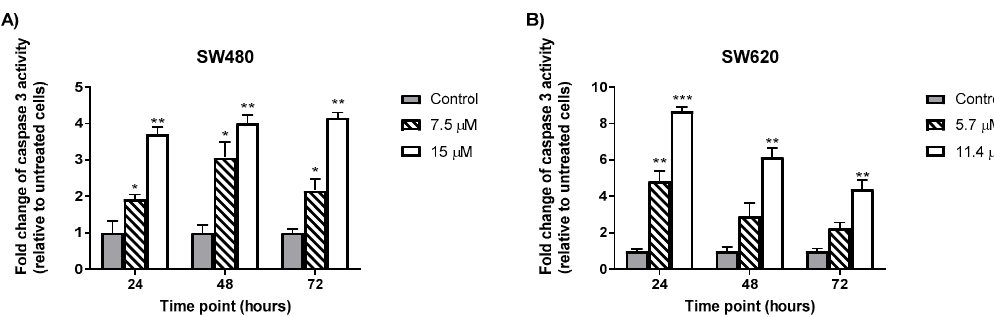
Figure 7. MS13 increases caspase-3 activity at di ff erent time points in SW480 ( A ) and SW620 ( B ) cells. Experiments were performed in duplicates and compared between two independent experiments. Asterisk indicate statistically significant (* for p ≤ 0.05, ** for p ≤ 0.01, *** for p ≤ 0.001 and **** for p ≤ 0.0001) di ff erences between data sets for each treatment dose. Error bars indicate mean ± SEM.